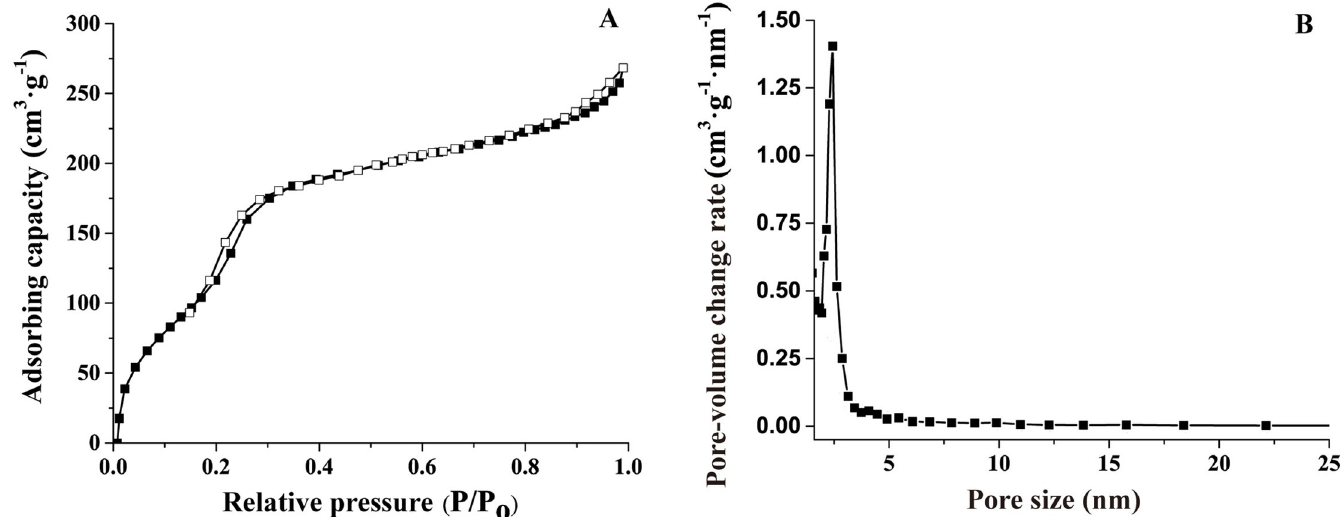
Fig 4. Nitrogen adsorption-desorption isotherms (A) and pore size distribution curve (B) of MMS.